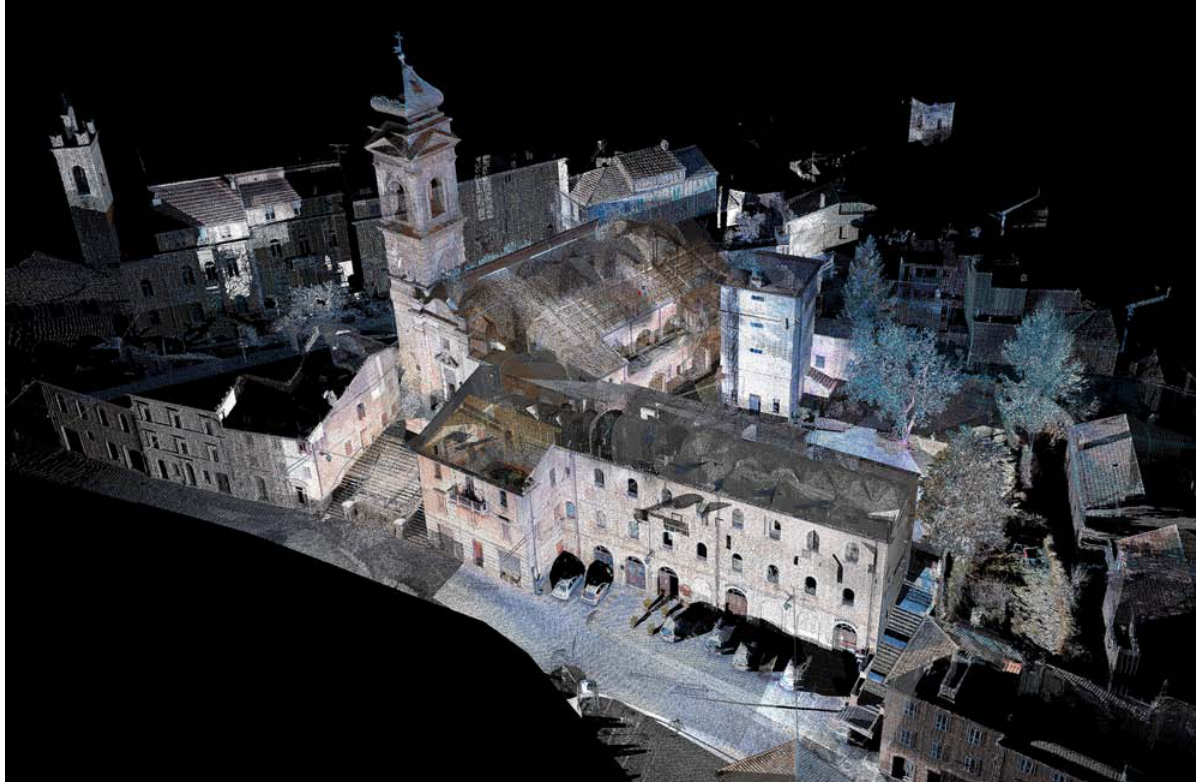
Figure 3. Merged point cloud from TOF scanner